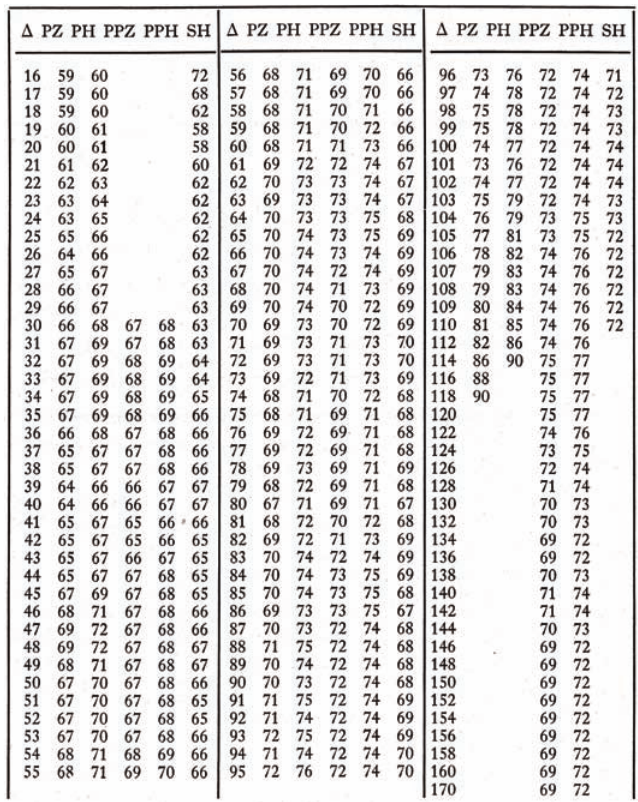
Figure 2. Nomogram for the direct determination of m wave amplitudes. The corresponding values of M tion (6) are also